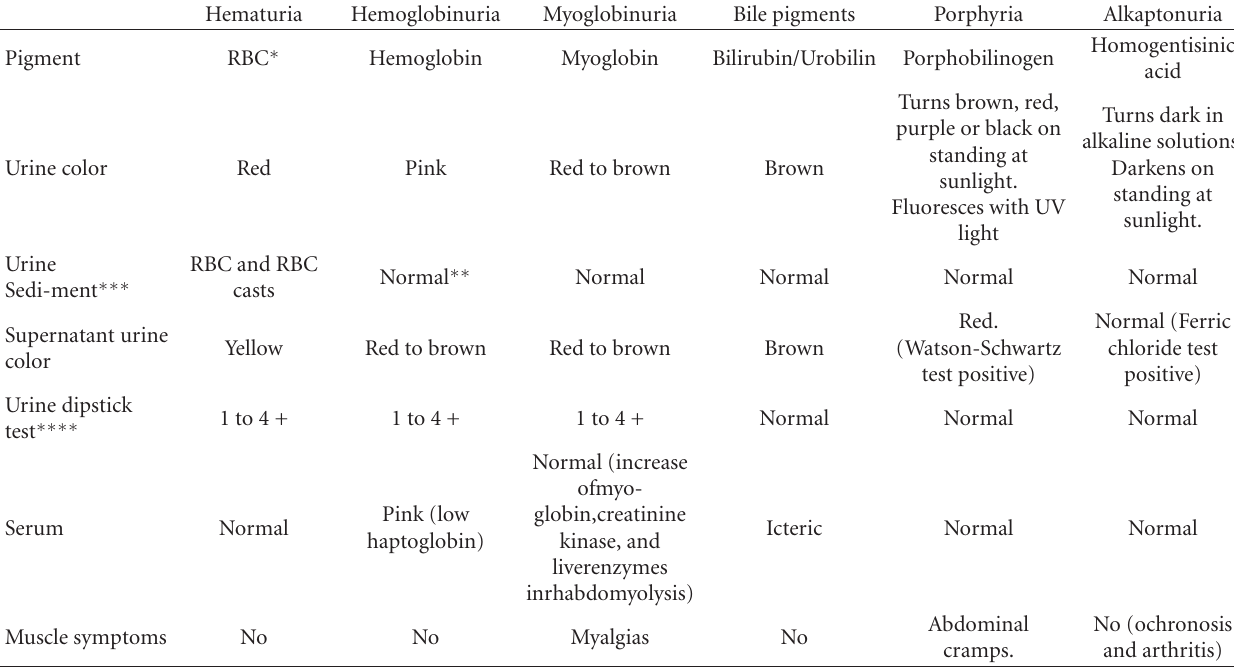
Table 1: Di ff erential diagnosis of